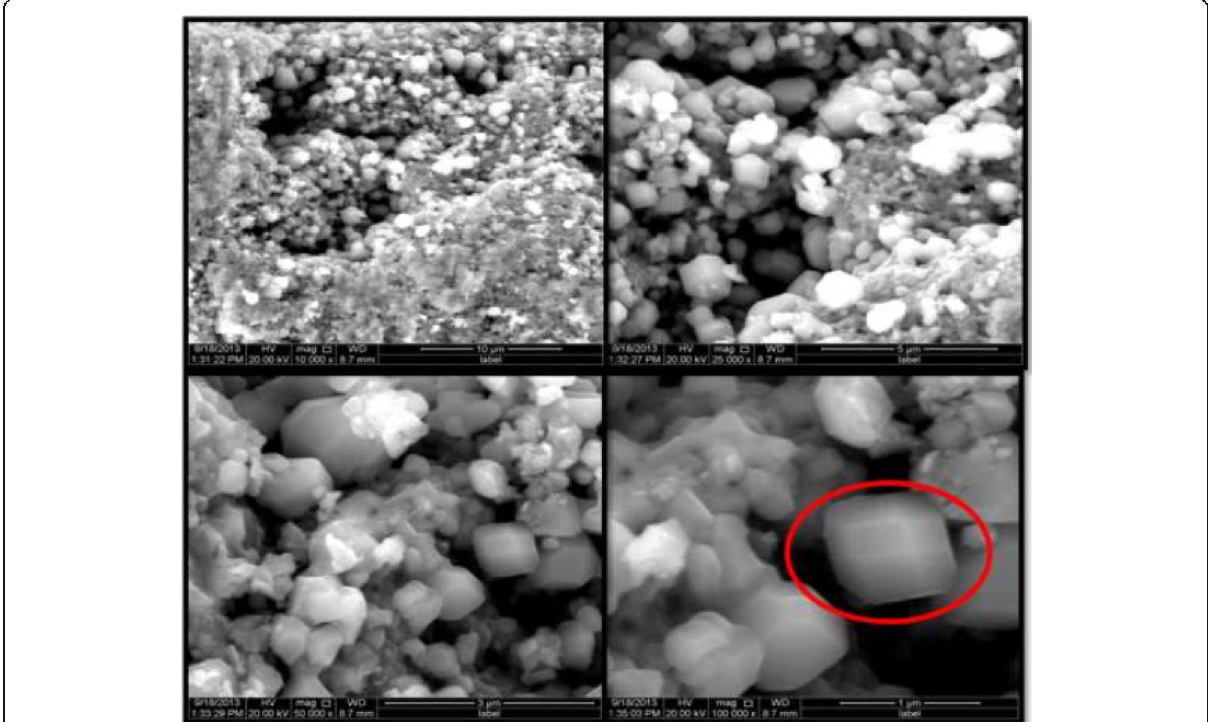
Fig. 1 SEM images of copper oxide sample at different